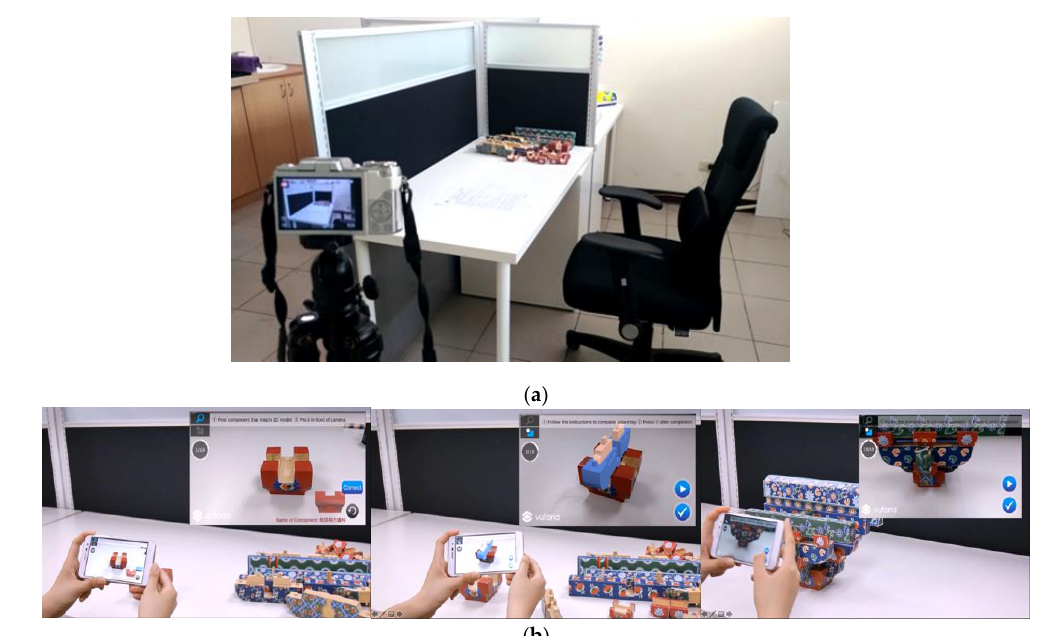
Figure 11. ( a ) Experimental environment and ( b ) a typical AR-assisted experiment session.